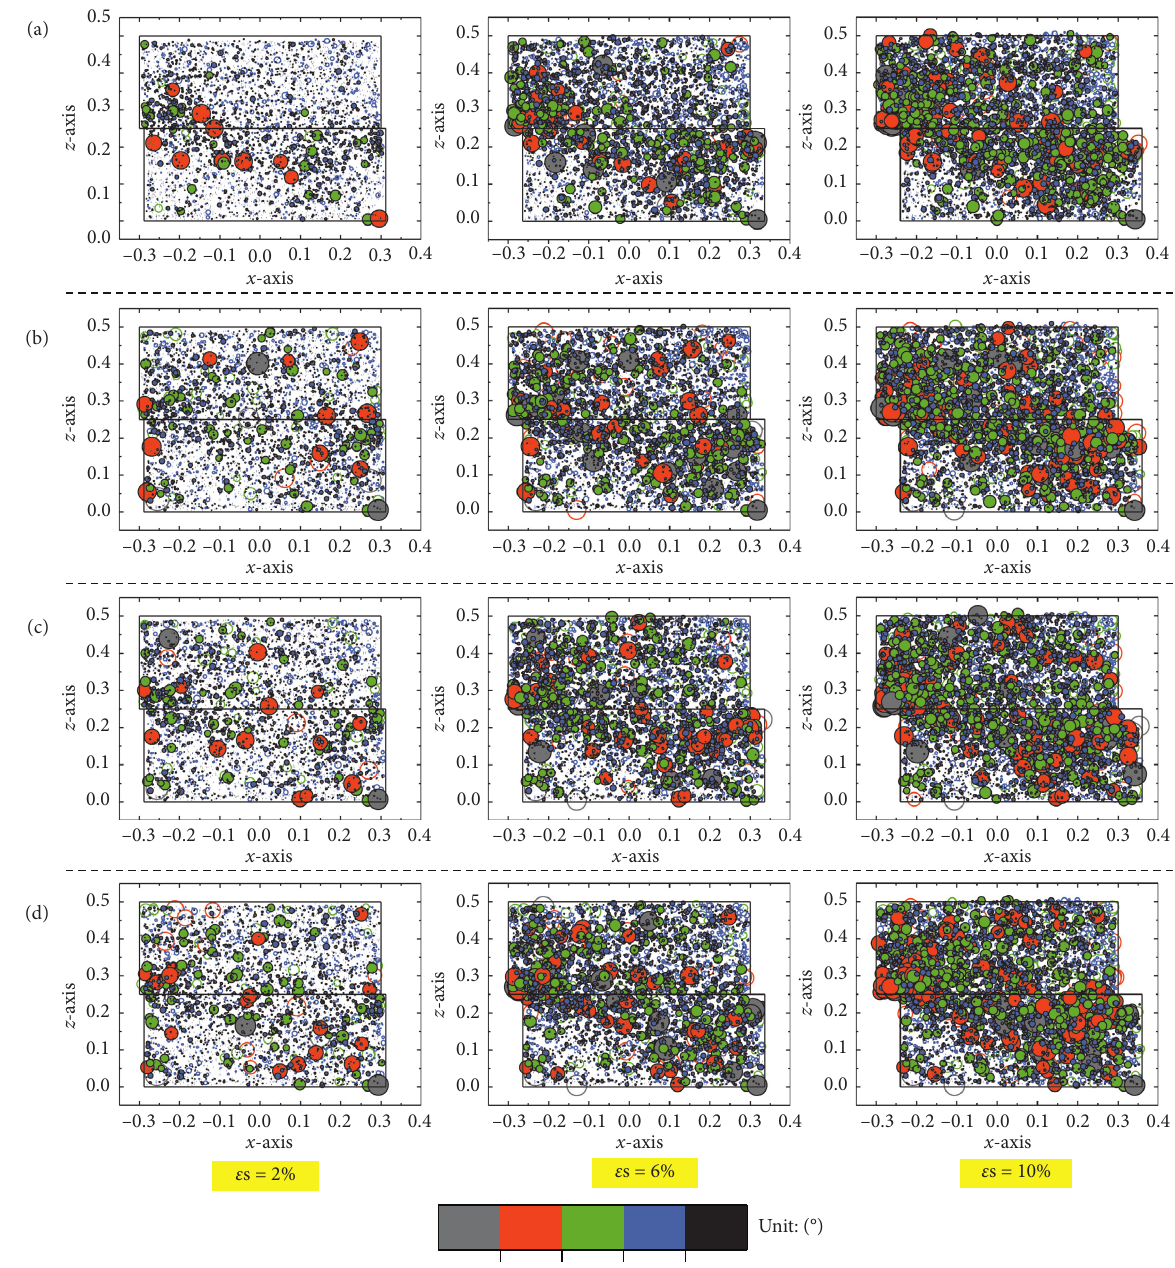
Figure 10: The rotation of particles at ε